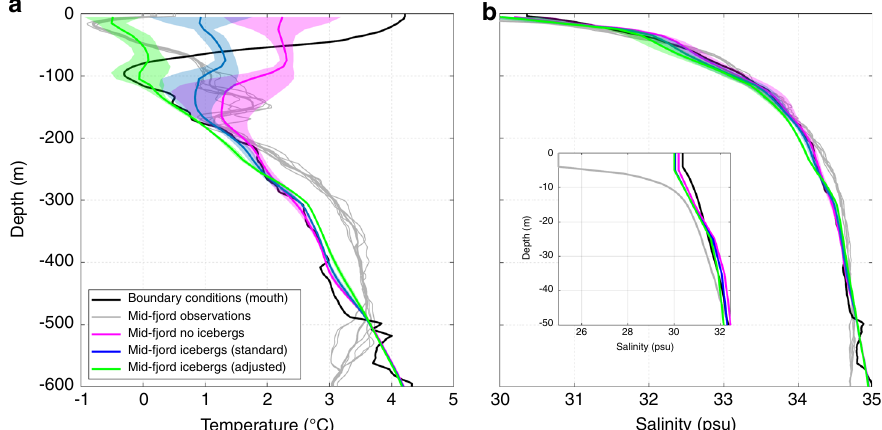
Fig. 7 Comparison of modelled and observed temperature and salinity. The magenta lines show modelled temperature and salinity in simulations without icebergs, whilst the blue and green lines show simulations with icebergs using the standard and adjusted melt rate parameter values, respectively ( a temperature; b salinity). The black line shows the average of conductivity-temperature-depth casts at the fjord mouth used as model boundary conditions (locations in Fig. 1a). The grey lines are from casts obtained approximately midway along the fjord (locations in Fig. 1a) roughly contemporaneously to those at the mouth. Modelled mid-fjord pro fi les were extracted in approximately the same locations as the mid-fjord casts. Shading indicates the standard deviation between simulations with both ‘ channelised ’ and ‘ distributed ’ drainage con fi guration scenarios and with runoff varying from 400 – 2000 m 3 s − 1 , which encompasses the estimated runoff into the fjord (~1000 m 3 s − 1 ) at the time the observations were obtained, based on RACMO2.3 modelled runoff. Inset in b shows salinity (without shading) in the upper 50